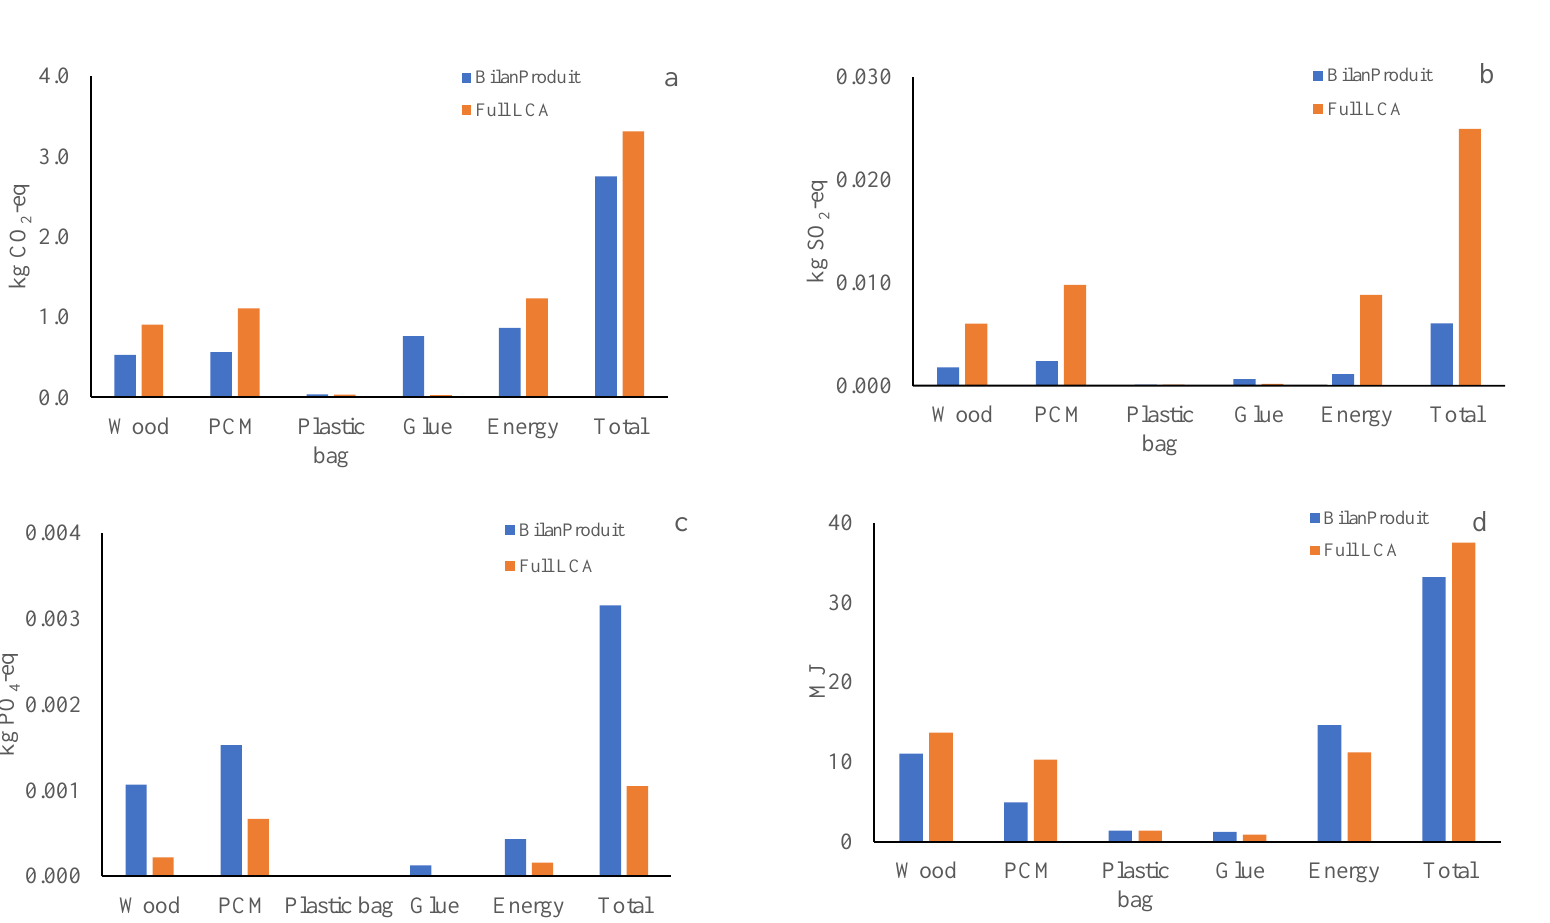
Figure 4. Results comparison of the full LCA and Bilan Produit tool based on four similar impact categories, ( a ): Global Warming Potential (GWP); ( b ): Acidification; ( c ): Eutrophication; and ( d ): Non-Renewable Energy.